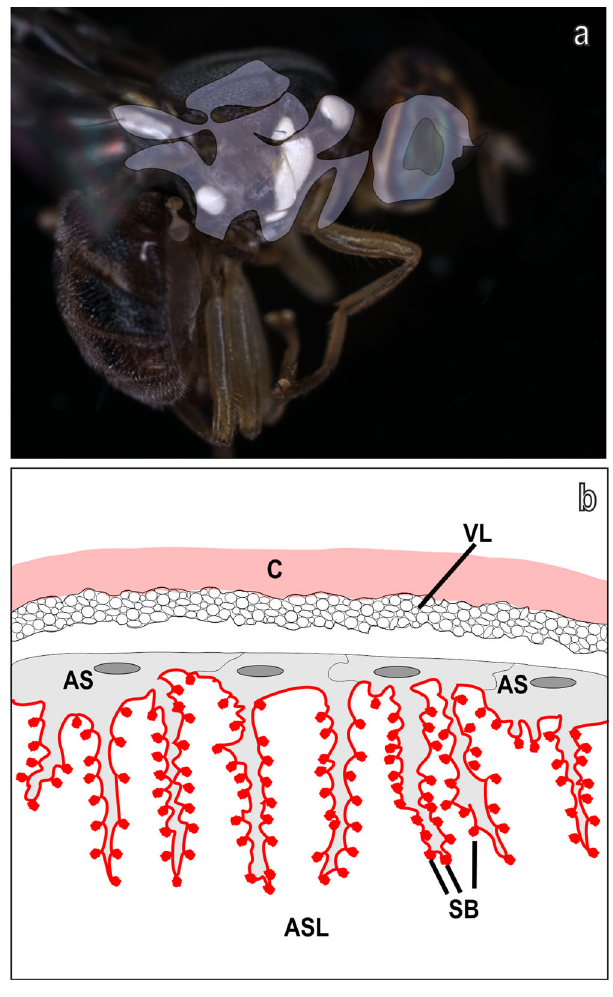
Fig. 9 Bactrocera oleae air sacs and schematic structure of their modi fi ed internal structure. a Development of air sacs (in grey, modi fi ed from ref. 33 ) in relation with the distribution of white patches; b Scheme showing the structure of the modi fi ed air sac (AS) with arborisations and spiny beads (SB) underlining the transparent cuticle (C) in correspondence of the white patches. VL, vesicular layer. The red line shows the thin layer of epicuticle bordering the arborisations and the spiny beads facing the air sac lumen (ASL) fi lled